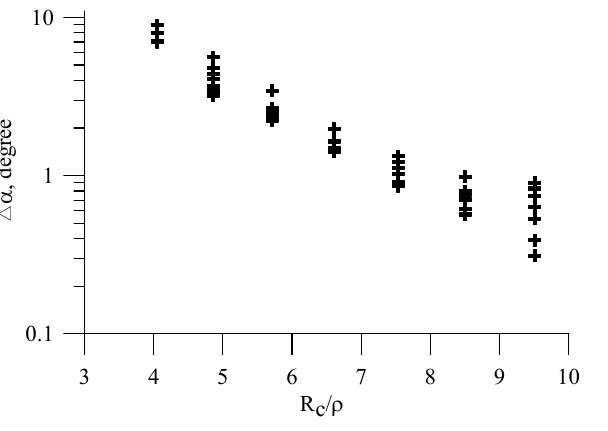
Fig. 6. R c /ρ –dependence of the phase-averaged pitch angle changes (pitch angles reduced to the magnetic equator) after one crossing of the field reversal region calculated by tracing the 30- keV protons in the T01 magnetic field at midnight meridian. Initial pitch angles varied from 0 ◦ to 35 ◦ (with 5 ◦ step), whereas the ini- tial phase for each initial pitch angle varied from 0 ◦ to 360 ◦ (in 20 ◦ steps).